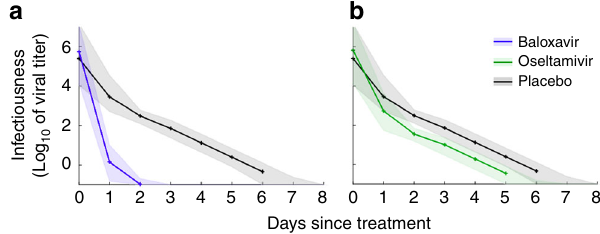
Fig. 2 Early antiviral treatment reduces the infectiousness of in fl uenza virus. Reduction of infectiousness by treatment with a baloxavir or b oseltamivir compared with treatment with placebo. Patients were assumed to be treated within 48 h of symptom onset, with the same scheduling as in the clinical trial 8 . Lines and shading indicate medians and interquartile ranges across 1014 stochastic simulations, corresponding to the sample sizes of 427, 377, and 210 for the baloxavir, oseltamivir, and placebo clinical trial groups,